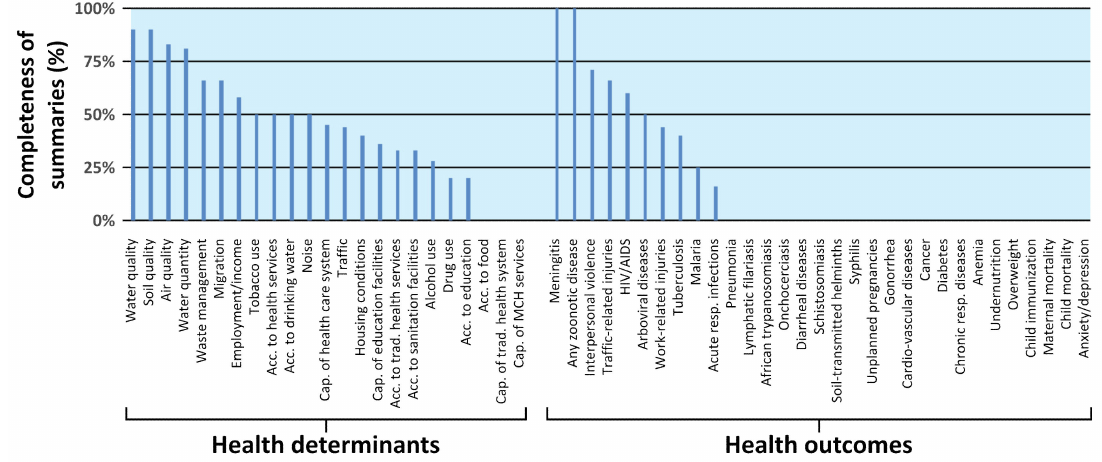
Figure 6. Inclusion of health aspects among the 12 analyzed executive summaries of IA reports. Percentages (bar heights) indicate the number of executive summaries addressing the health aspects relative to the number of full texts considering that aspect. Bar widths indicate the number of full texts addressing the respective health aspect (used as denominator for the bar heights). Missing bars indicate 0% inclusion in the summaries. Acc. = access; Cap. = capacity; MCH = maternal and child health; resp. = respiratory; trad. =